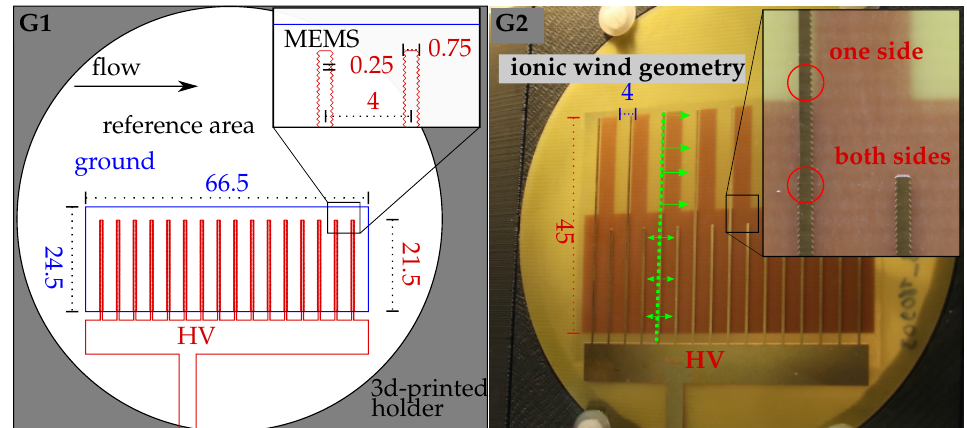
Figure 3. Sketch of the SDBD geometry G1 ( left ) and a photograph of the SDBD manufactured with geometry G2 ( right ). The high-voltage (HV) electrodes are at the substrate top (red) and the ground electrode on the backside (blue) of the substrate. All dimensions are shown in millimeters. The green arrows on the photograph indicate the direction of the ionic wind generated by one electrode.